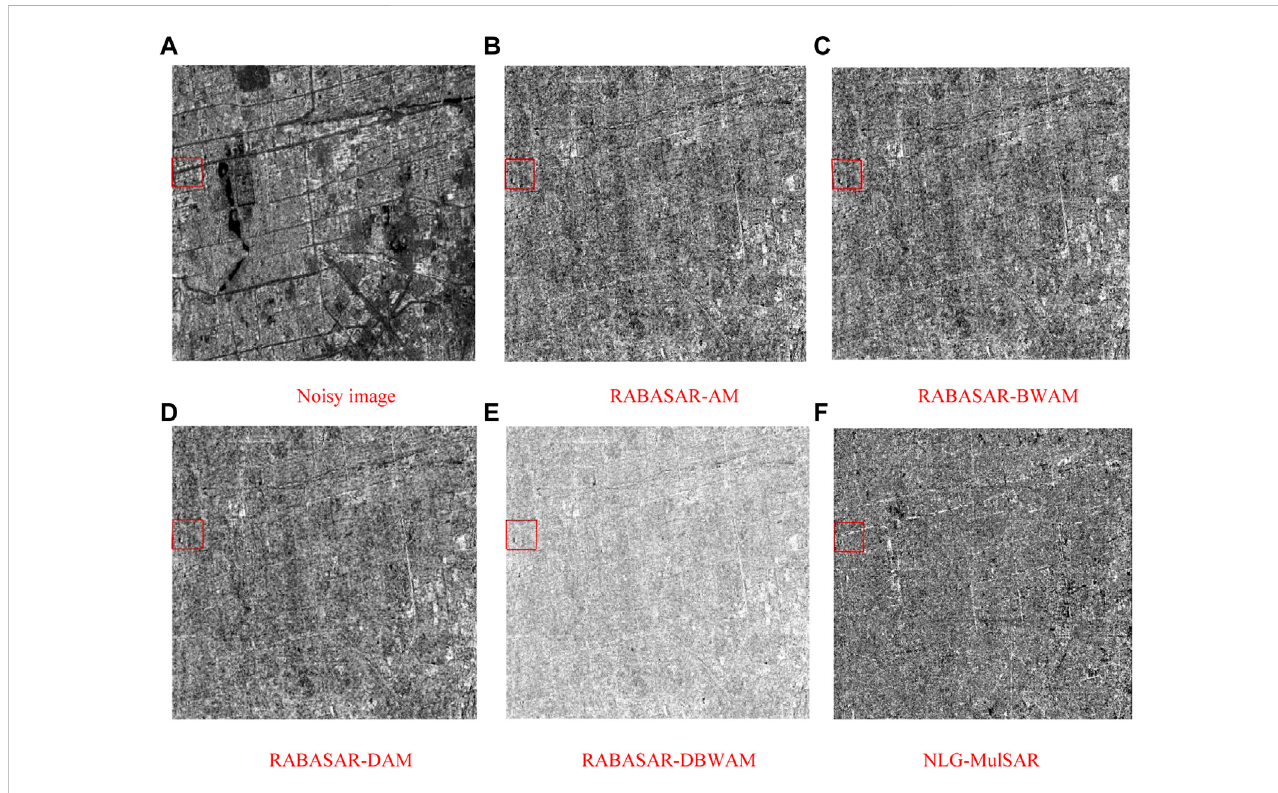
FIGURE 4 The ratio images generated by different de-noised methods for the GF-3 SAR image (A) Noisy image, (B) RABASAR-AM, (C) RABASAR-BWAM, (D) RABASAR-DAM, (E) RABASAR-DBWAM, (F)